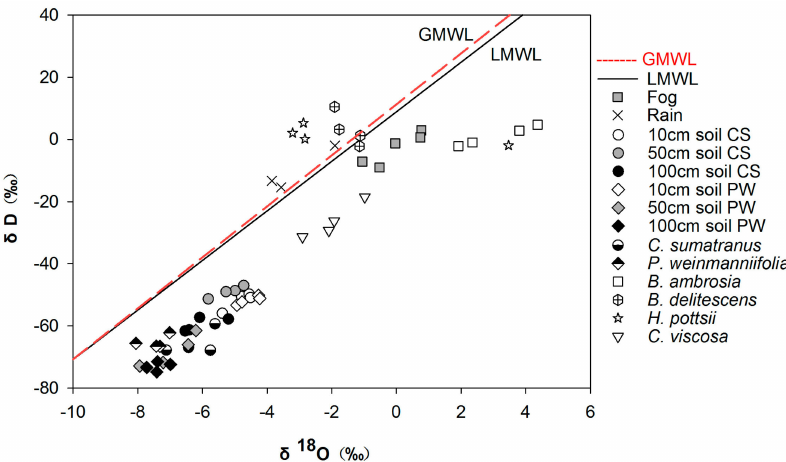
Figure 3. Hydrogen ( δ D) and oxygen ( δ 18 O) stable isotope composition of fog ( n = 5), rain ( n = 3), plant xylem ( n = 24), and soil water ( n = 24) samples. The reference line is the local meteoric water line (LMWL) (adapted from Liu et al. [48]) and global meteoric water line (GMWL).